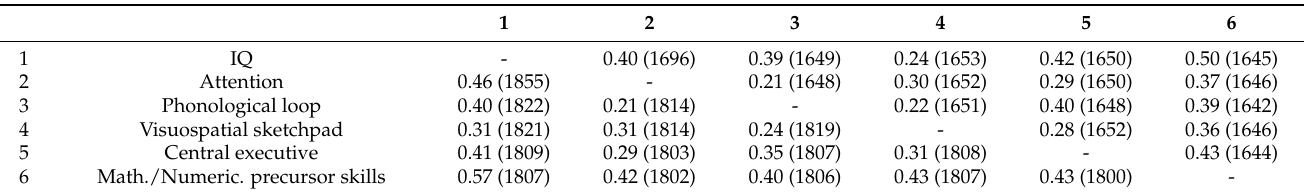
Table 4. Intercorrelations (Pearson) between variables t1 (below diagonal) and between variables t2 (above diagonal) ( n ).